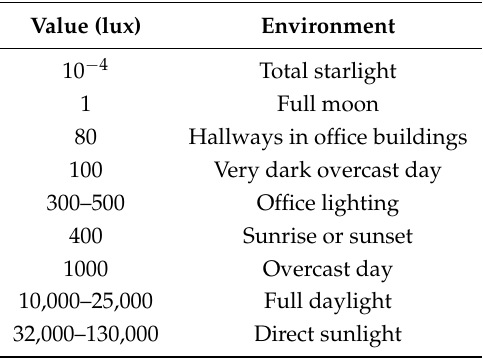
Table 1. Illuminance at different